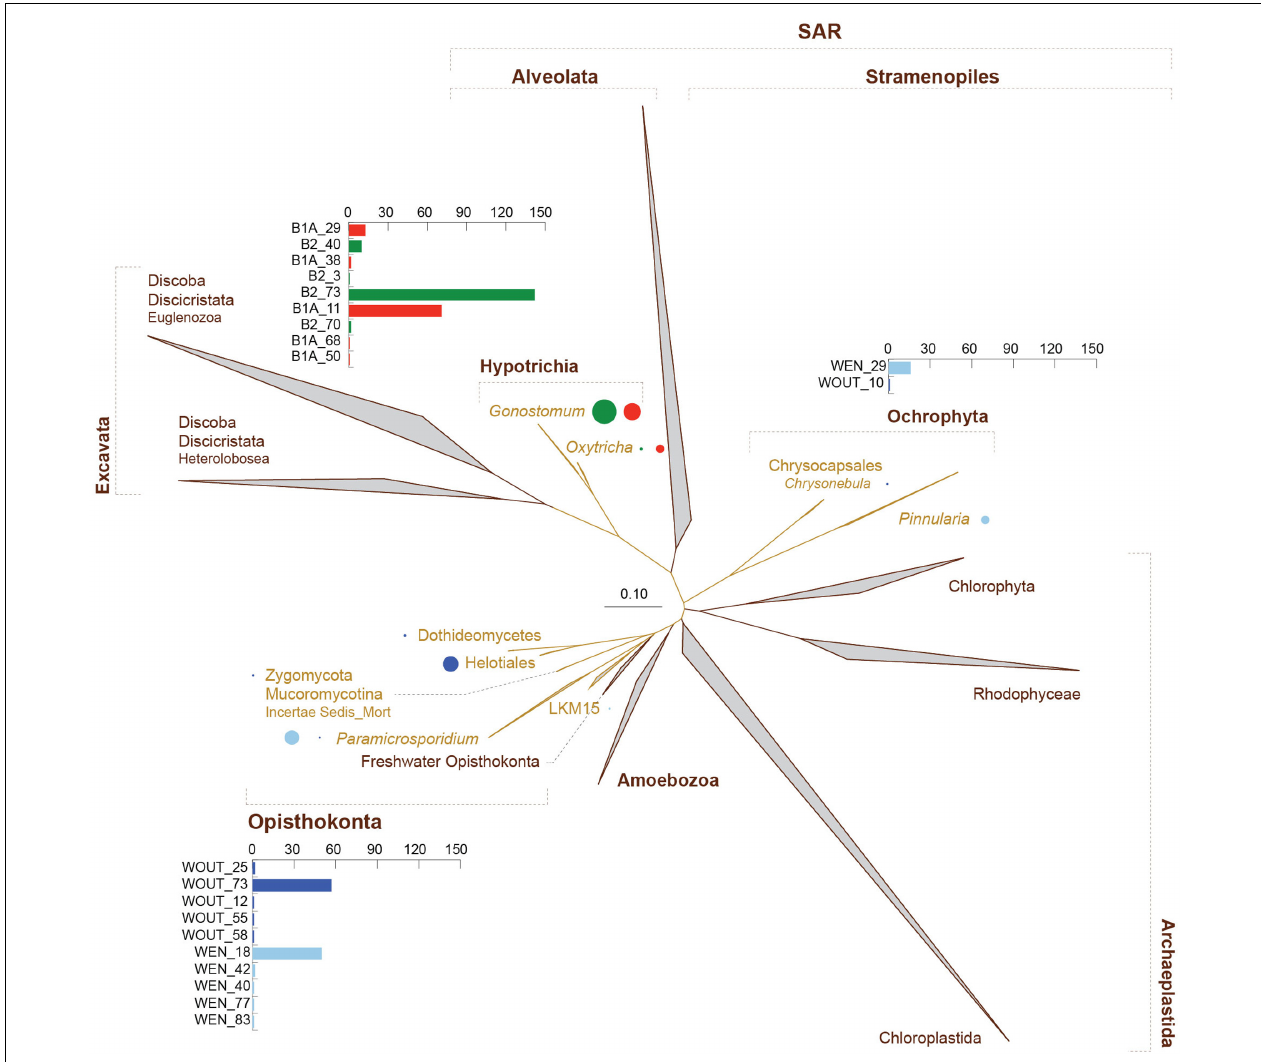
FIGURE 6 | Phylogeny of 18S rRNA full-length genes recovered from biofilm (B1A and B2) and water samples (WOUT and WEN). All clades from which microbial eukaryotes had been reported in AMD ecosystems were included. The groups containing newly detected microbial signatures are highlighted in yellow. Bar graphs represent number of sequences per OPU. Bubble charts are proportional to the abundance of each specified taxa. Scale bar represents changes per site